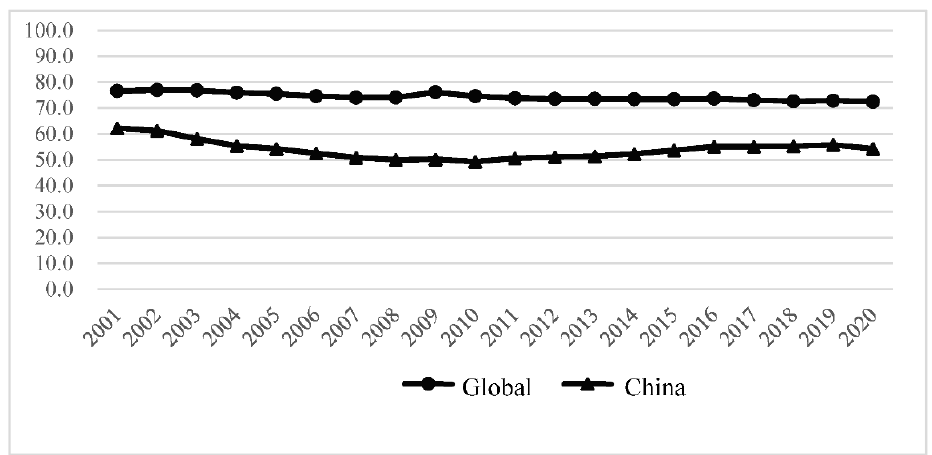
Figure 1. Proportions of final consumption expenditure of GDP globally and in China. Data source: World Bank.